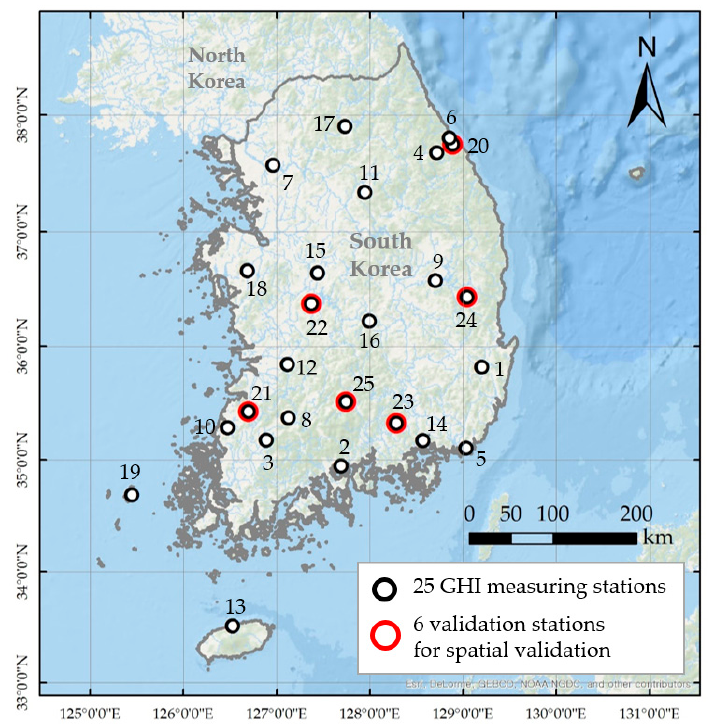
Figure 2. The location of selected weather stations in Korea. GHI: global horizontal solar irradiance.